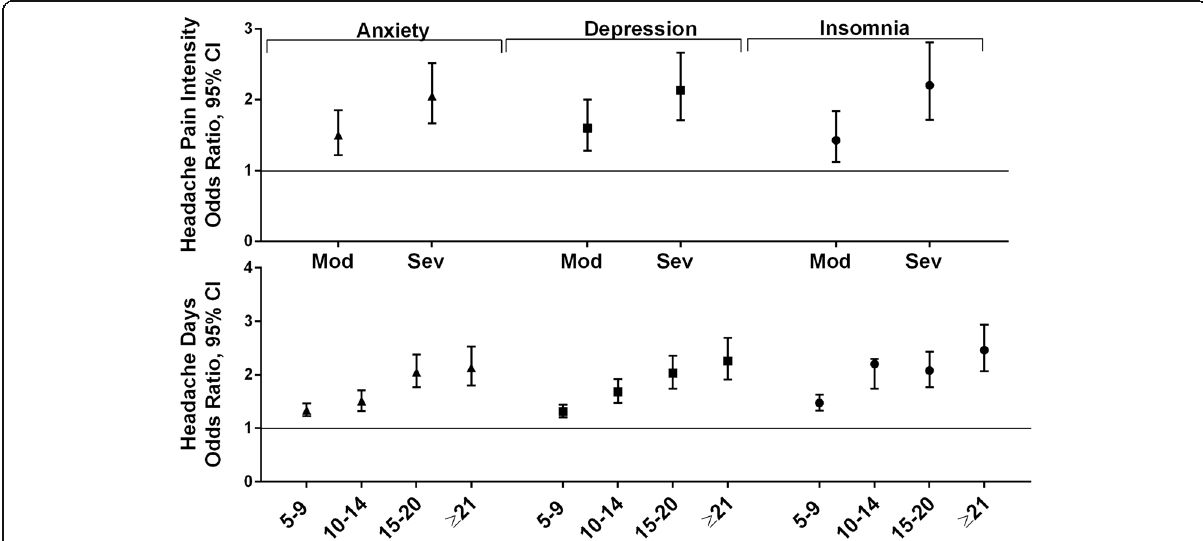
Fig. 5 Among persons with migraine the odds ratios (and 95% CI) for comorbid psychiatric and sleep conditions*. Fully adjusted models with sociodemographic, characteristics (age, gender, Hispanic origin, race, marital status, employment, household income), headache pain intensity and headache frequency. Reference groups are low headache pain intensity for headache pain intensity and low frequency headache (1 – 4 MHDs) for headache